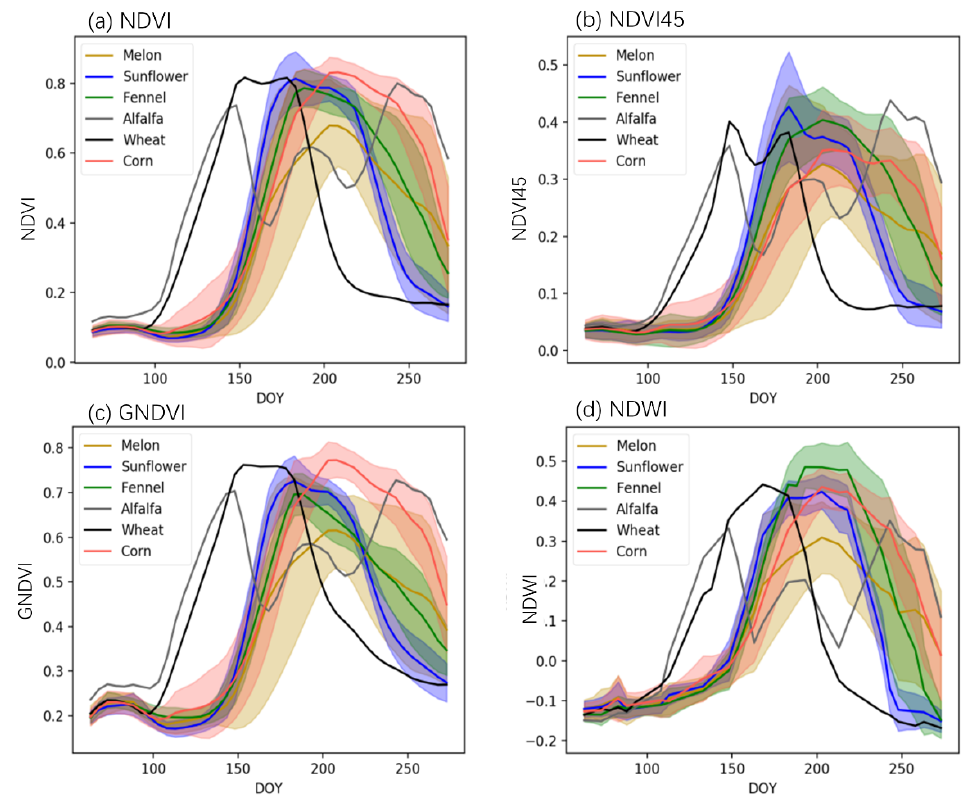
Figure 6. Five-day time series of the ( a ) NDVI, ( b ) NDVI45, ( c ) GNDVI, and ( d ) NDWI for the six main crops in the Shiyang River Basin in 2019. The shading around each line indicates the standard deviation of the vegetation indicator in space. The shadings of the wheat and alfalfa are not shown to better show the index distribution of the other four crops.